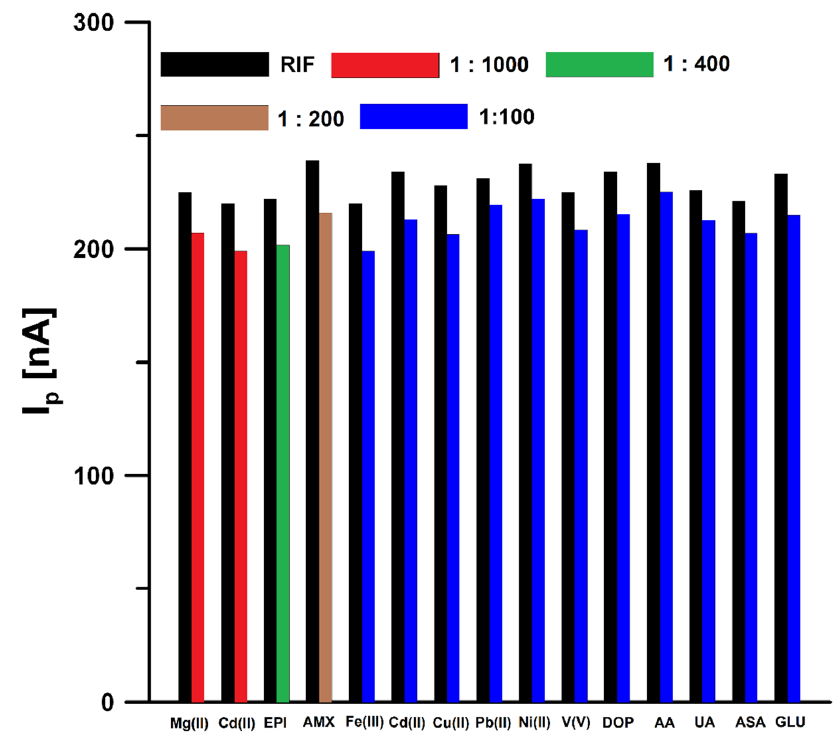
Figure 8. Histogram bars of the RIF peak current in the presence of interferents.